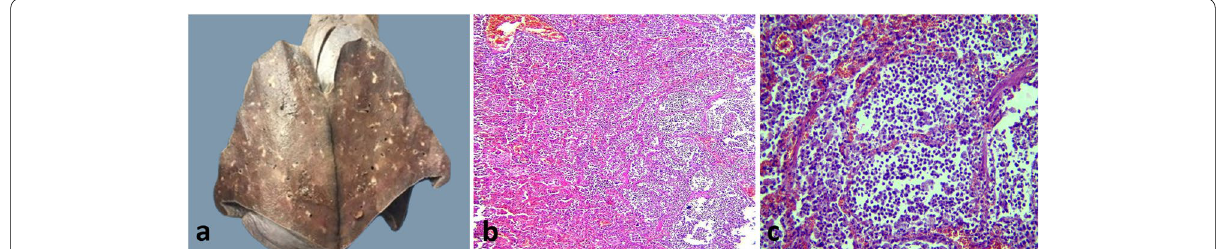
Fig. 1 Bacterial bronchopneumonia. a A Lung with multiple yellowish foci, b histopathological picture of septic bronchopneumonia showing the pulmonary alveoli and bronchi densely infiltrated by polymorphonuclear leukocytes in (H&E collecting inside the alveoli